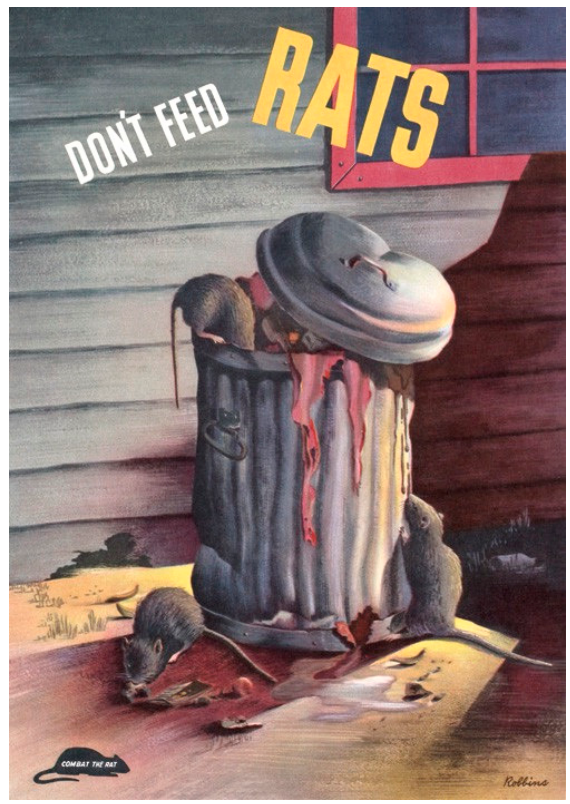
Figure 9. Don’t feed rats. Combat the rat. This US Public Health Service poster from 1944 encourages the proper disposal of food waste.